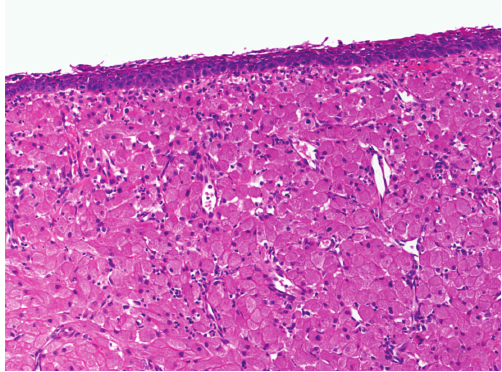
Figure 1: Intraoperative picture showing two large fleshy peduncu- lated masses arising from the upper and lower alveolar ridges.